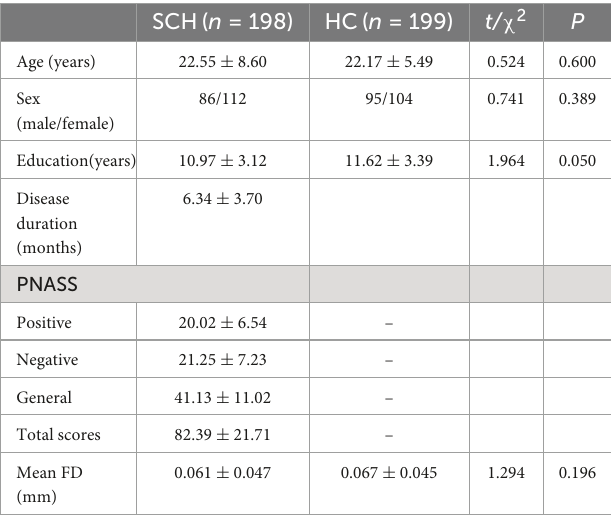
TABLE 1 Demographic and clinical data of SCH and HC groups [Mean (SD)].